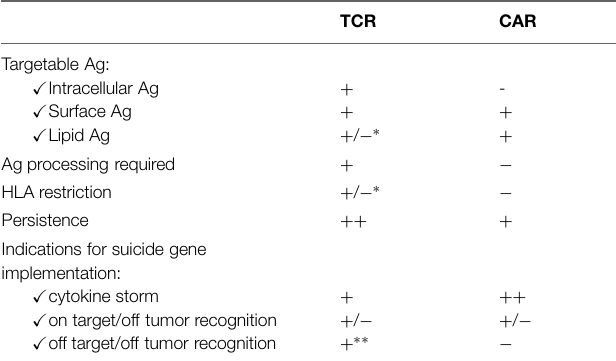
∗∗ potentially abrogated by TCR gene